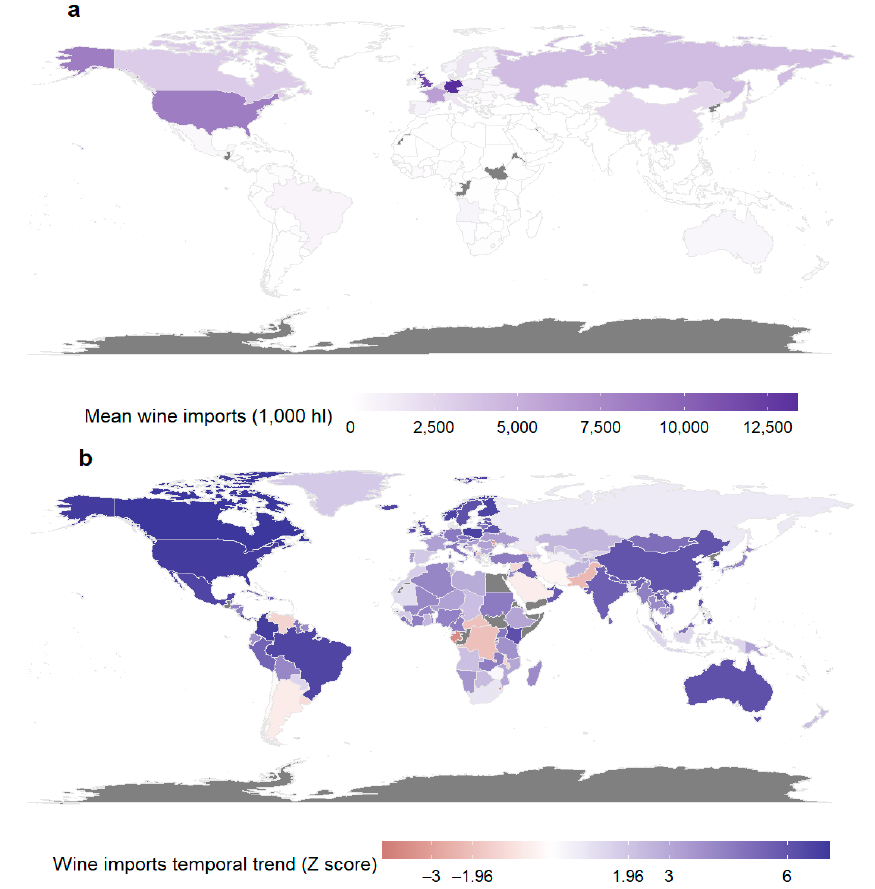
Figure 5. Wine import representation for each country, including mean long-term quantities ( a ); and Z-score for each country, signifying the extent of the temporal trend over 27 years ( b ). Countries in grey represent no data.